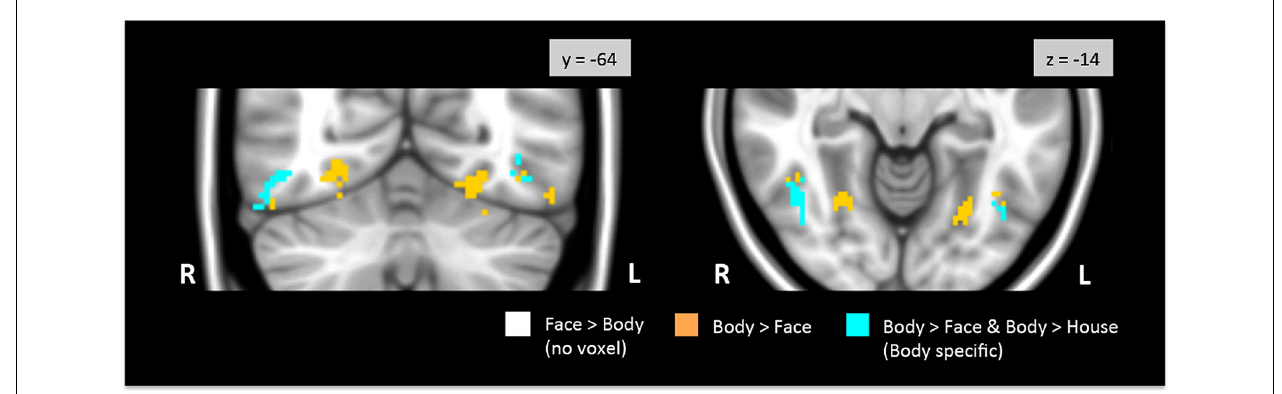
FIGURE 3 | Direct face vs. body contrasts within theTOFC ROI. No significantly activated voxels were found in the face > body contrast. Medial and lateral activations were observed in the body > face contrast (orange and